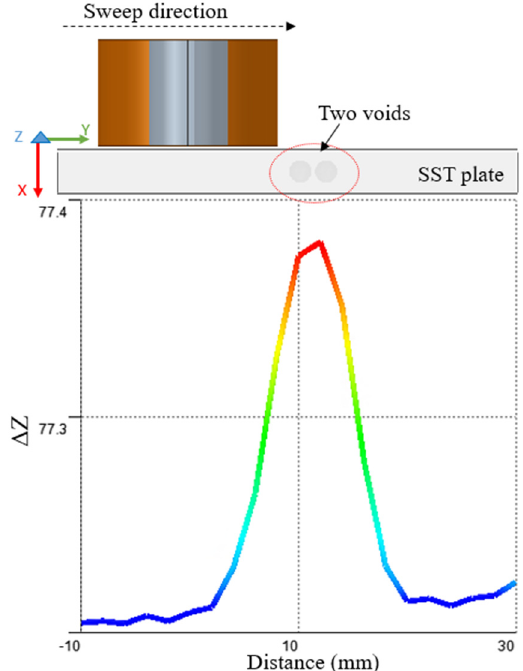
Figure 16. Sweep over position on the top of the plate with two voids besides each other in the same region.